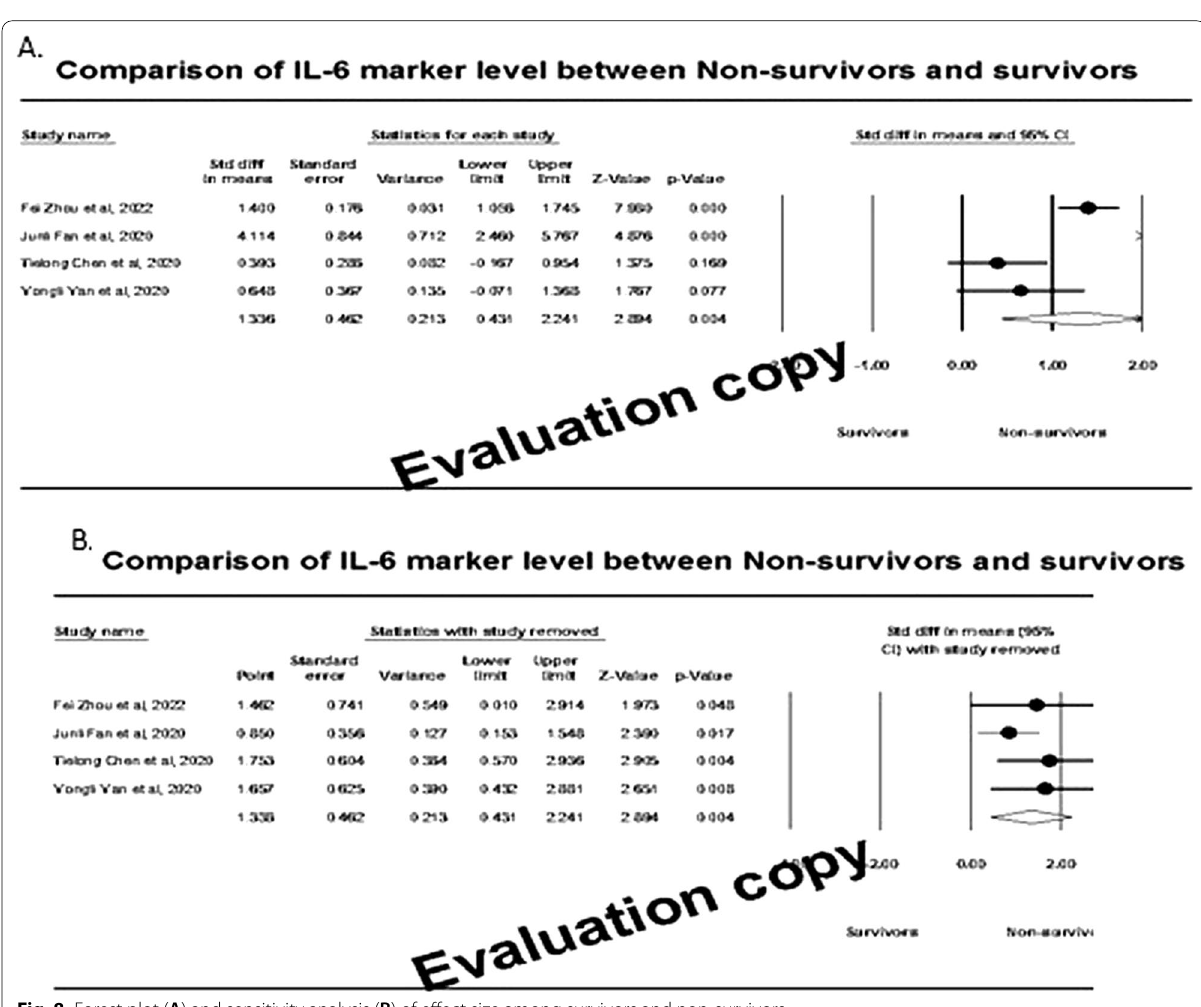
Fig. 8 Forest plot ( A ) and sensitivity analysis ( B ) of effect size among survivors and